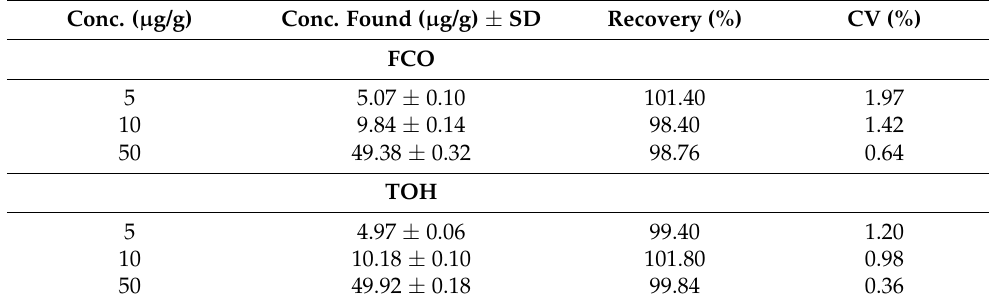
Table 2. Determination of the accuracy of FCO and TOH for GC-MS approach (mean ± SD; n = 3). Conc. ( µg/g ) Conc. Found ( µg/g ) ± SD Recovery (%) CV